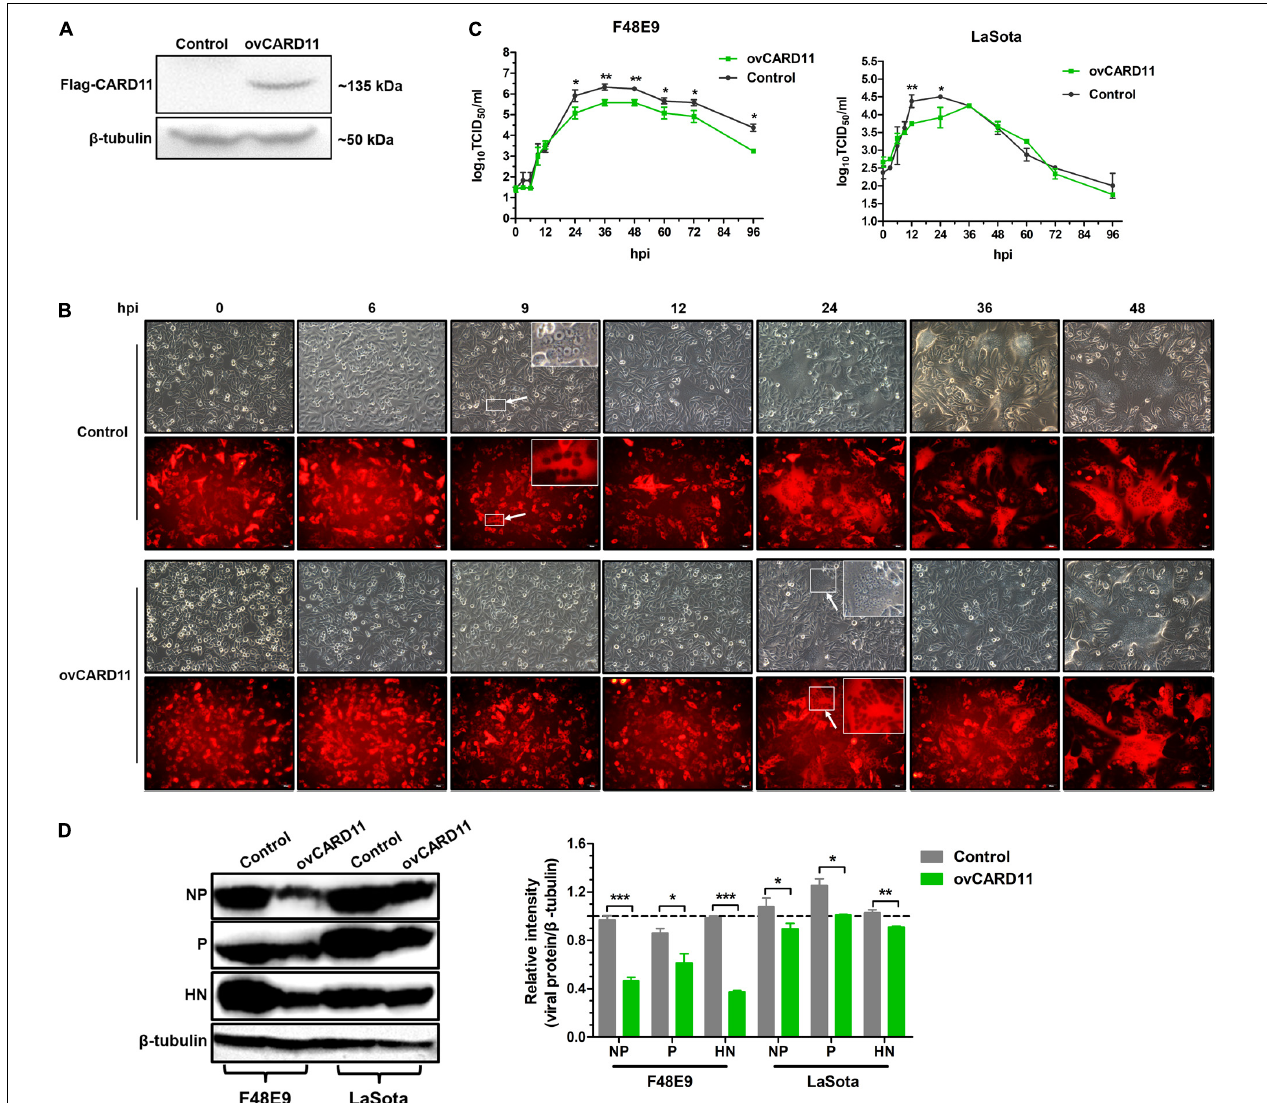
FIGURE 2 | CARD11 overexpression inhibits viral replication. (A) The protein expression of CARD11 was detected with an anti-Flag mouse mAb through western blot in selected control and ovCARD11 cells after three rounds of puromycin selection. (B) CPE in F48E9 (0.01 MOI)-infected control and ovCARD11 cells. The syncytia indicated by white arrows were zoomed on the top right corner. Scale bar = 50 µ m. (C) The viral titers in F48E9 (0.01 MOI) and LaSota (1 MOI)-infected control and ovCARD11 cells. (D) The viral NP, P, and HN proteins in F48E9 (0.01 MOI) and LaSota (1 MOI)-infected control and ovCARD11 cells at 36 hpi were detected by a western blot assay. The expression levels relative to that of β -tubulin were analyzed by densitometry via ImageJ software. The results are presented as the mean ± SD of three independent experiments and were analyzed by two-tailed Student’s t -test. ns, not significant, * p < 0.05, ** p < 0.01, *** p < 0.001.